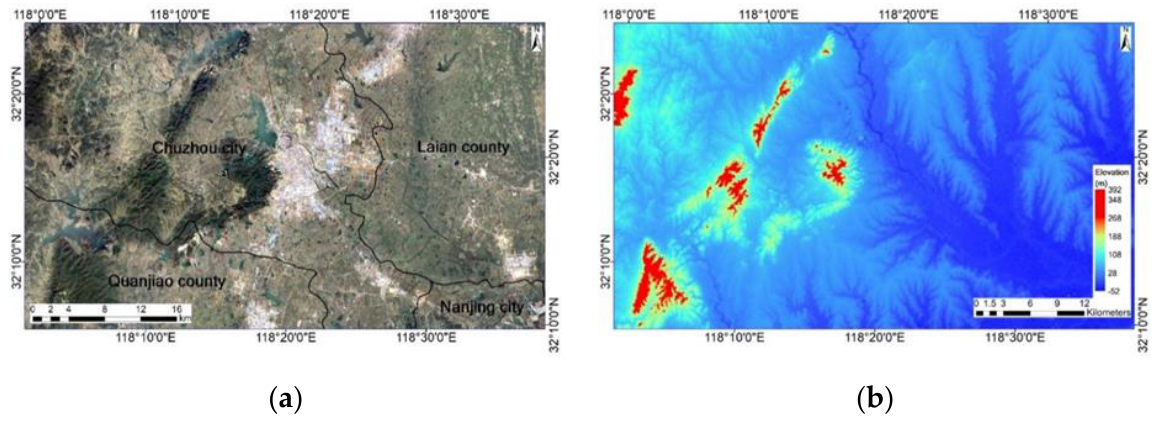
Figure 4. ( a ) Geographic location and ( b ) DEM of the study area.